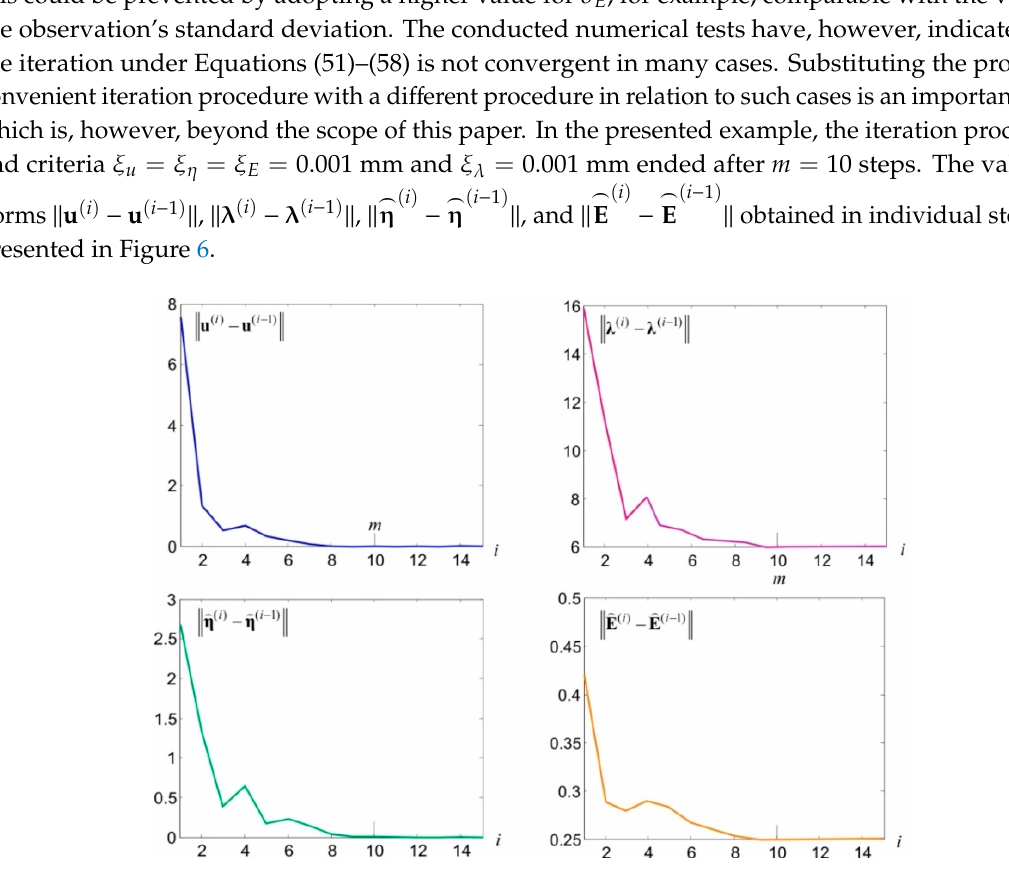
Figure 7. Monitored loading quay: ( a ) object’s photo (source: Google Maps), ( b ) free control network (FCN) diagram with ECPs marked. The calculations were performed for two measurement epochs: the year 1998 t α = and the year 2008 t β =